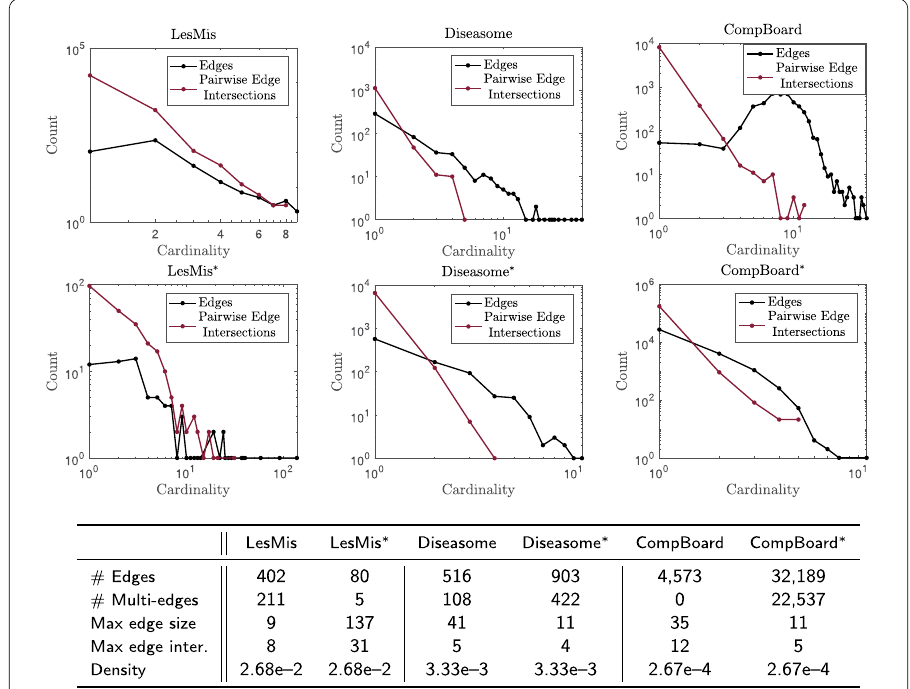
Figure 3 Plots : Edge and pairwise edge intersection distributions of LesMis, Diseasome, and CompBoard (top row) and their dual hypergraphs (bottom row). Table : Basic statistics on edge and multi-edge counts, the maximum edge and pairwise edge intersection cardinality, and density for each dataset and their dual